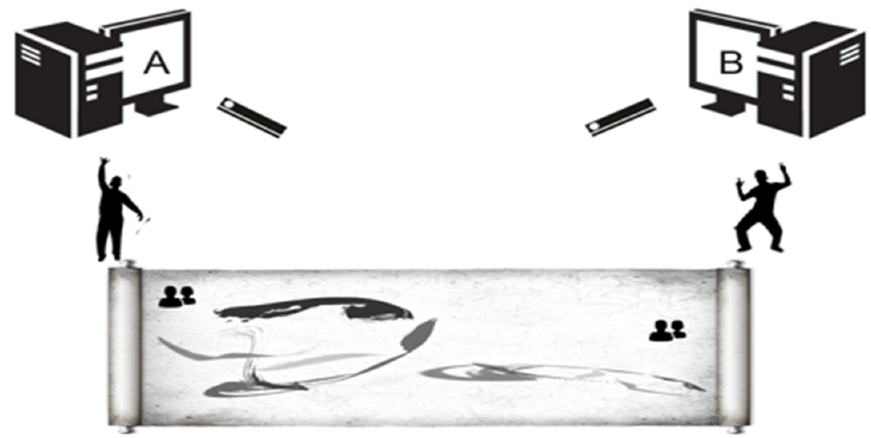
Figure 3. Sample system configuration.